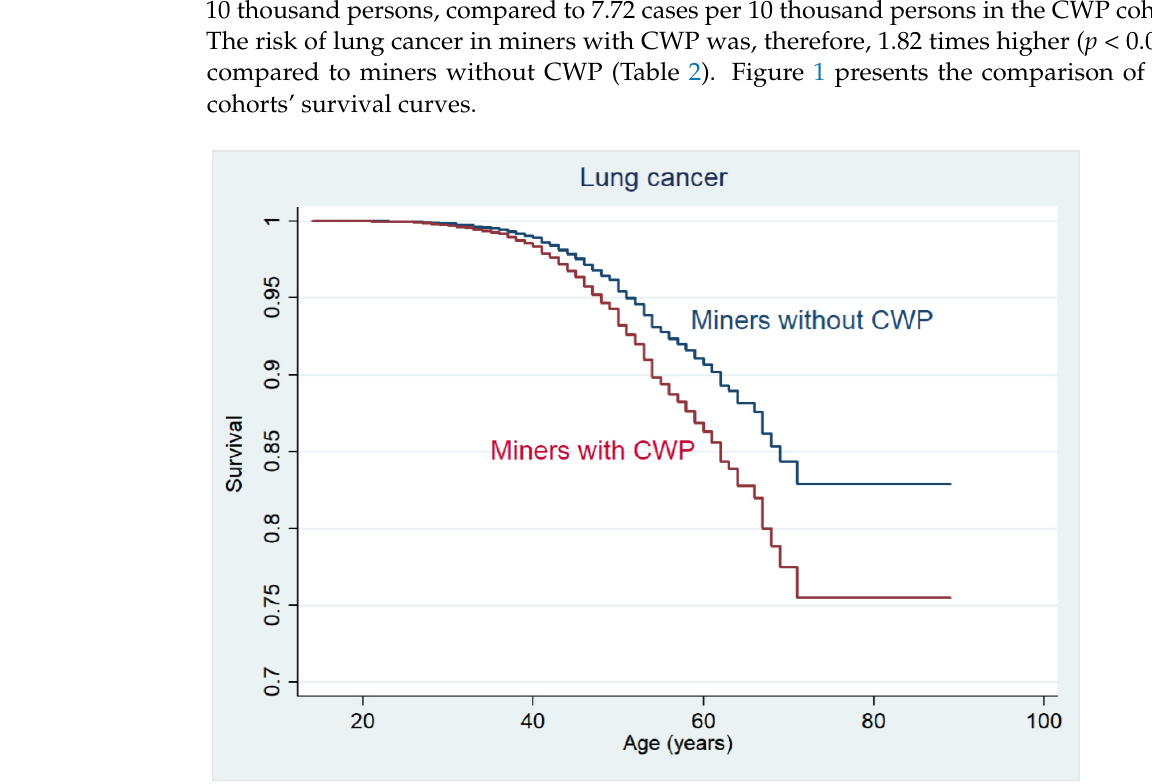
Figure 1. Survival curves for lung cancer-free survival in the cohorts of miners with coal-workers’ pneumoconiosis (CWP) (CWP cohort) and without CWP (No-CWP cohort).